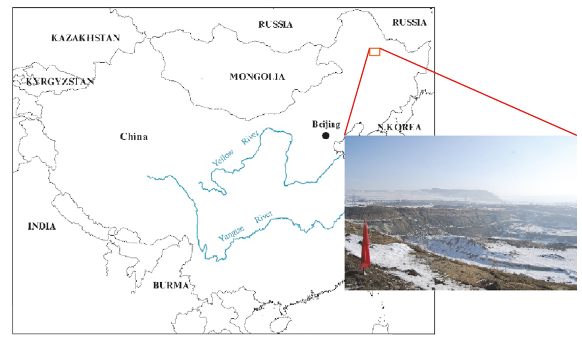
Figure 1: Location of the study